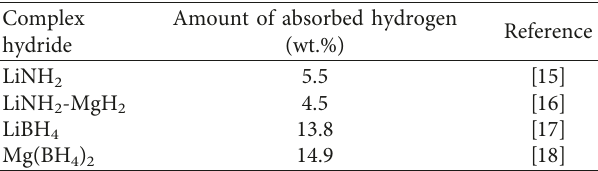
Table 2: Amount of absorbed hydrogen in nitrogen- and boron- containing complex hydrides. Complex Amount of absorbed hydrogen hydride (wt.%)